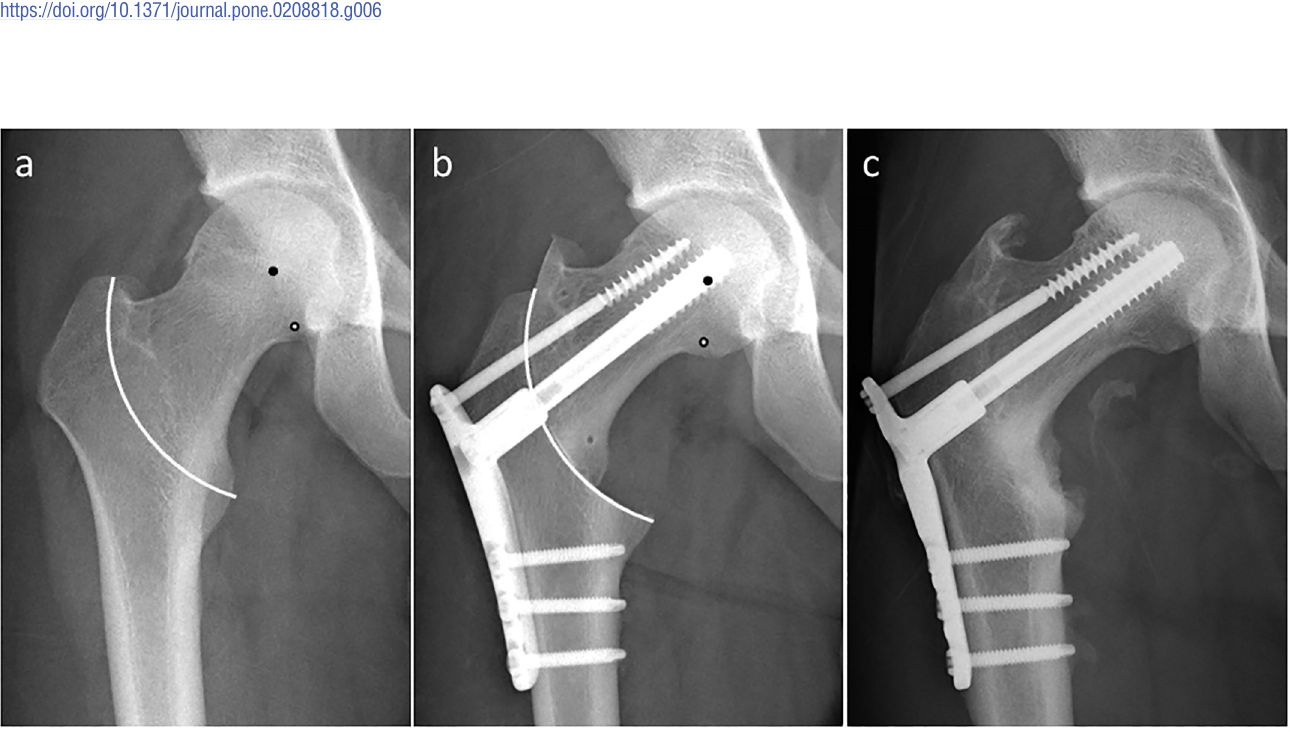
Fig 7. Radiographs of 20-year-old man who had steroid-associated osteonecrosis of the femoral head treated with curved intertrochanteric varus osteotomy. a) Before and b) after the operation. White line indicates the osteotomy arc. Black points indicate the center of the femoral head and white points indicate the center of the osteotomy arc. The actual leg shortening was -2.0 mm, whereas the theoretical leg shortening was -1.6 mm.